Question: Reading the figure, is the described quantity rising or falling?
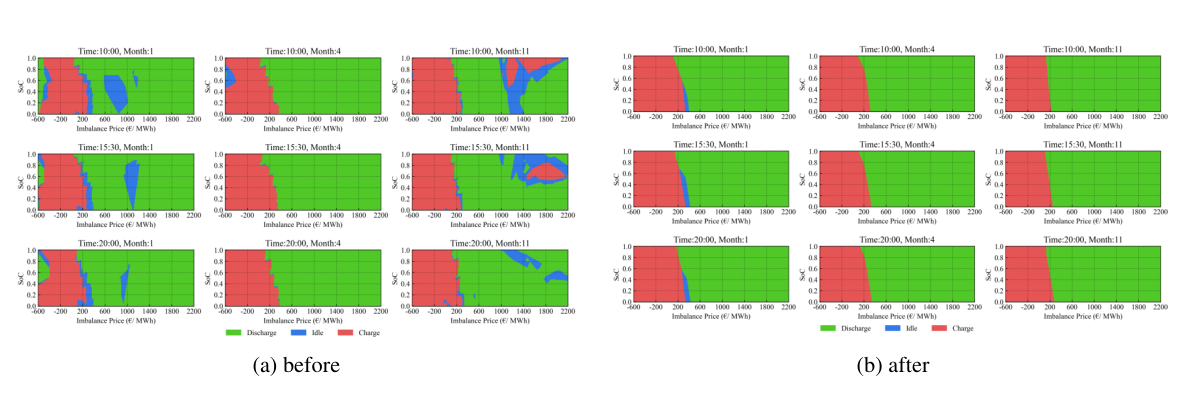
Answer: increasing